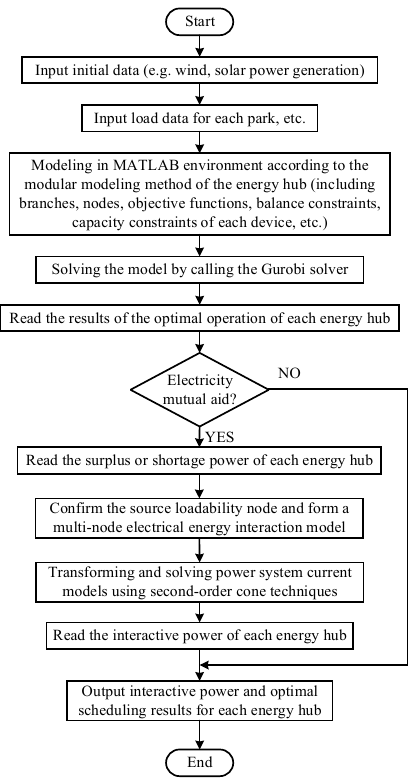
Figure 3. Flowchart for solving the optimal scheduling model of RIESG.